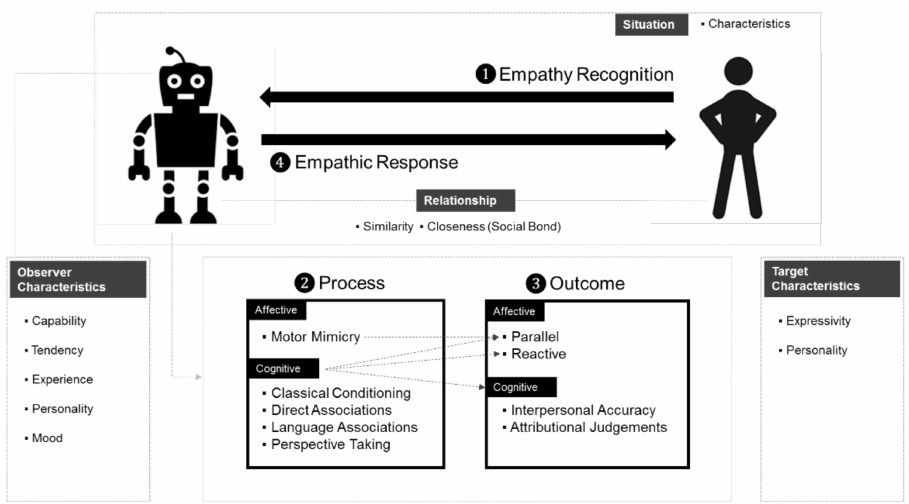
Figure 1. Conceptual model of empathy of